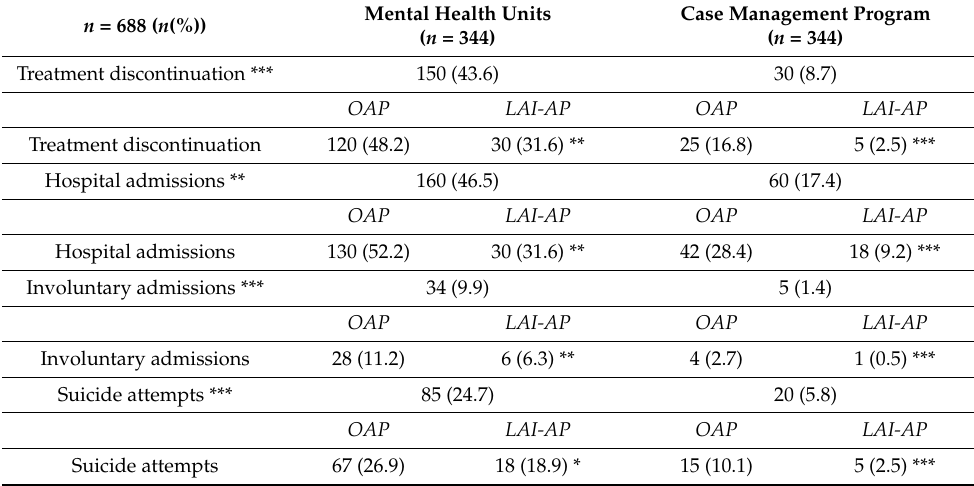
Table 3. Type of Antipsychotic (Oral vs. Lai), Treatment Discontinuation, Hospital Admissions, and Suicide Attempts.